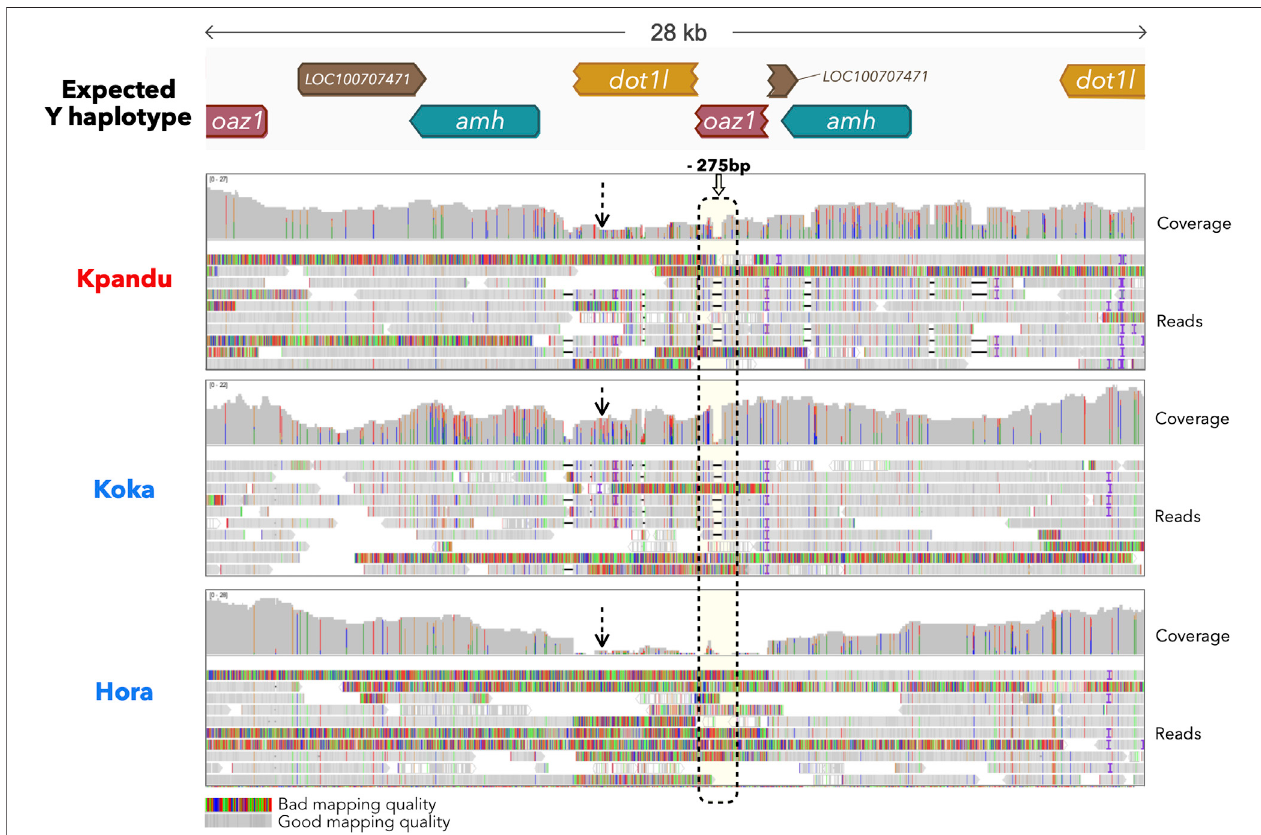
FIGURE 3 | IGV snapshot of long reads mapping obtained from the Kpandu (Lake Volta, Ghana) male, the Lake Koka (Ethiopia) male and the Lake Hora (Ethiopia) male. Reads were mapped onto a Y expected haplotype. Dashed arrows highlight the coverage level over the beginning of the Y speci fi c region. Reads mapping to the oaz1-dot1l chimera presenting a 275 bp deletion found in the oaz1 truncated copy (within the dashed rectangle) were labelled as Y-speci fi